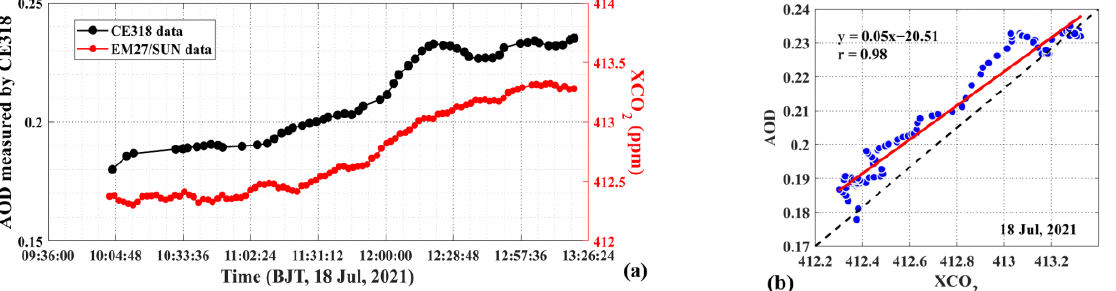
Figure 15. Measurement results of XCO 2 and AOD at the CRCS ground station on 18 July 2021 ( a ). The red dots represent the XCO 2 results measured by EM27/SUN, and the black scatter points represent the AOD results measured by CE318. ( b ) The correlation analysis result of XCO 2 and AOD.